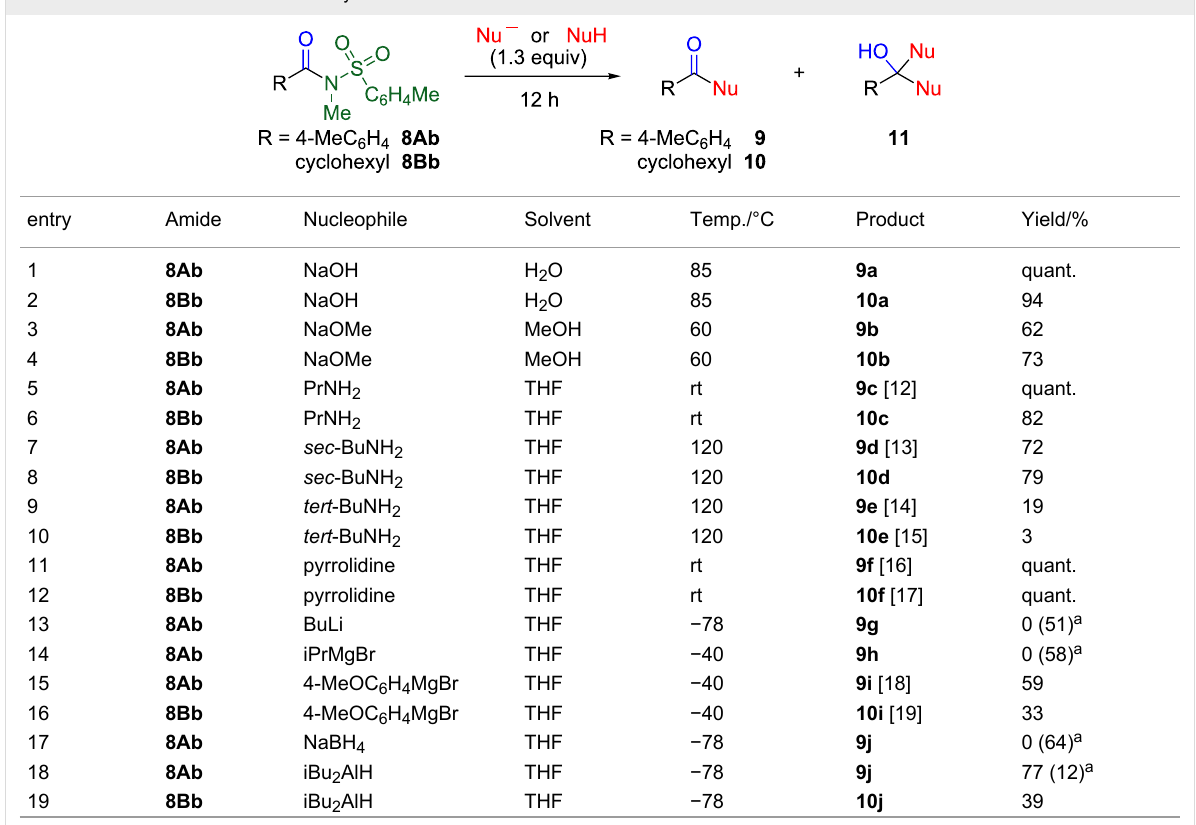
Table 2: Chemical conversions of N -methylamide to other